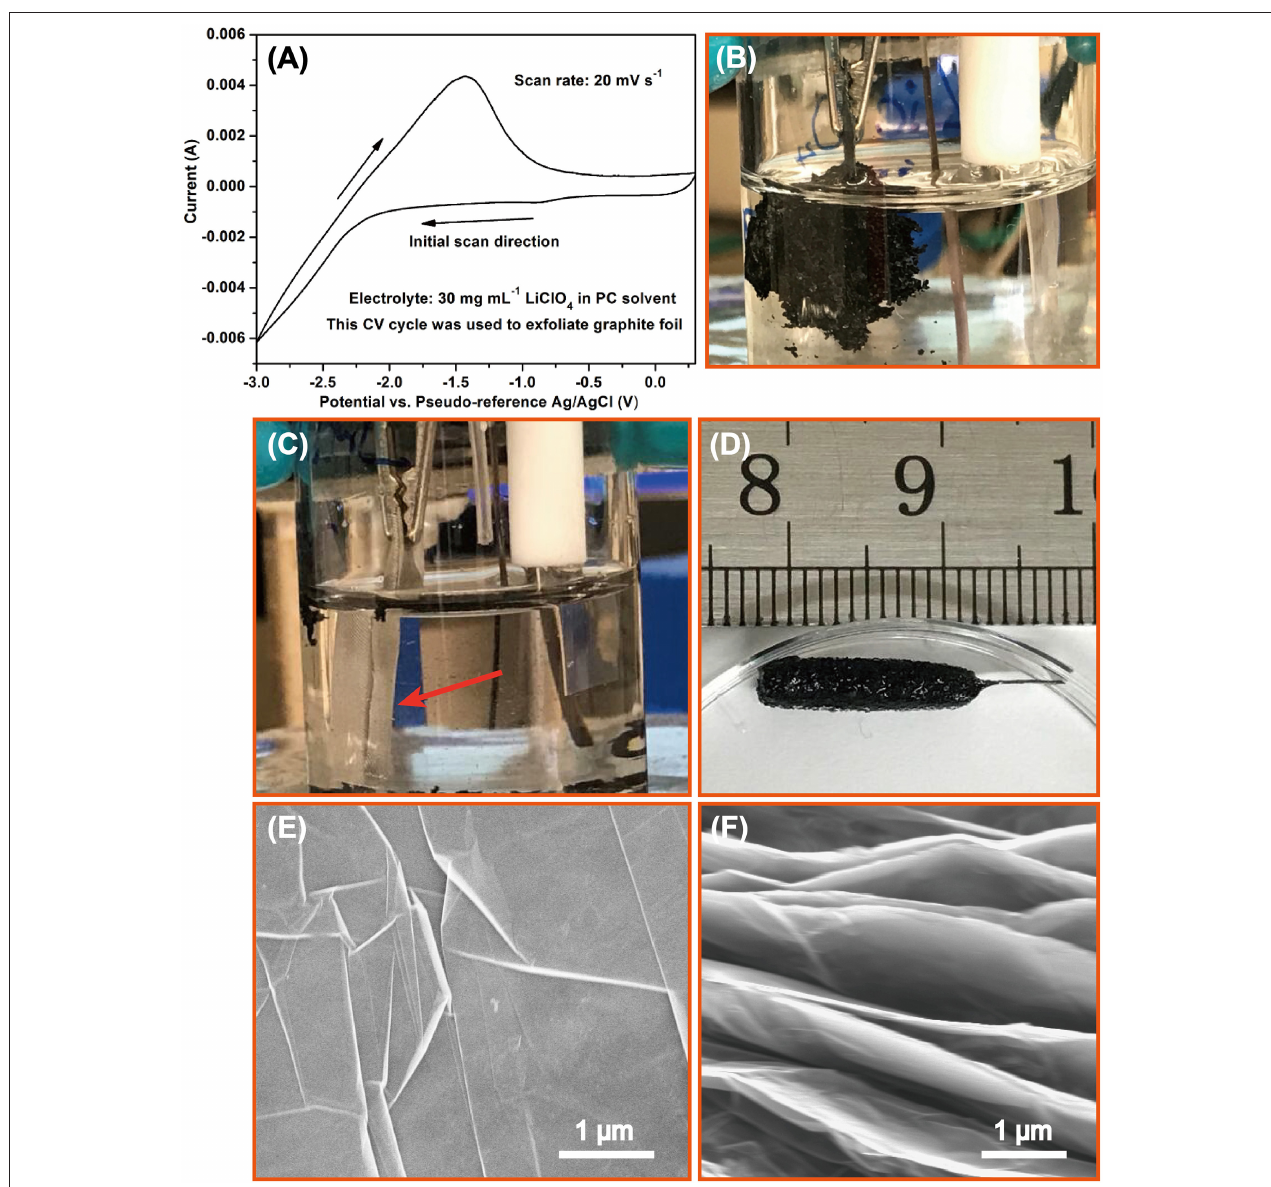
FIGURE 2 | (A) The CV curves designed for electrochemical exfoliation; (B) the exfoliated graphitic materials prepared with this CV method; (C) the electrochemical exfoliation conducted with the space confined strategy; (D) the exfoliated graphitic hydrogel obtained by the electrochemical exfoliation by wrapping the metallic gauze; graphite foil (E) before and (F) after